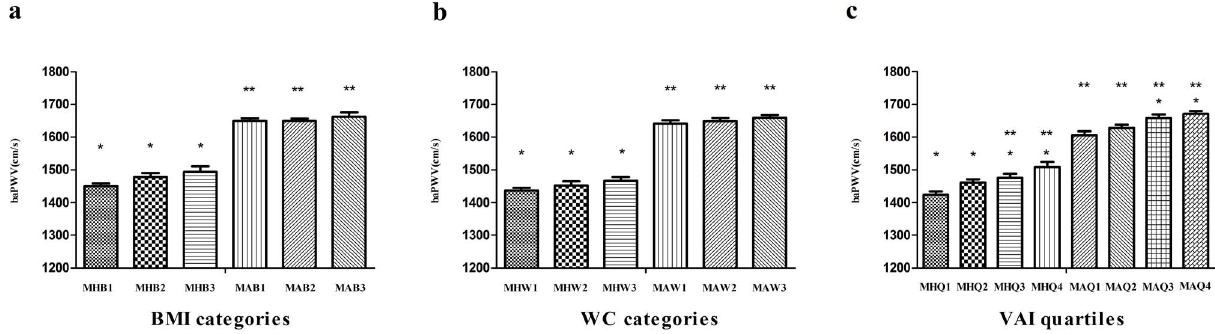
Figure 2. Association between body size phenotypes (combined consideration of BMI or waist circumference categories or visceral adiposity index quartiles and the absence or presence of the abnormal metabolic components) and brachial-ankle pulse wave velocity (mean ± s.e.) after adjustments for age and heart rate. MH, metabolically healthy individuals; MA, metabolically abnormal individuals; baPWV, brachial-ankle pulse wave velocity. * P , 0.01 for the comparison to the metabolically abnormal first category; ** P , 0.01 for the comparison to the metabolically healthy first category.